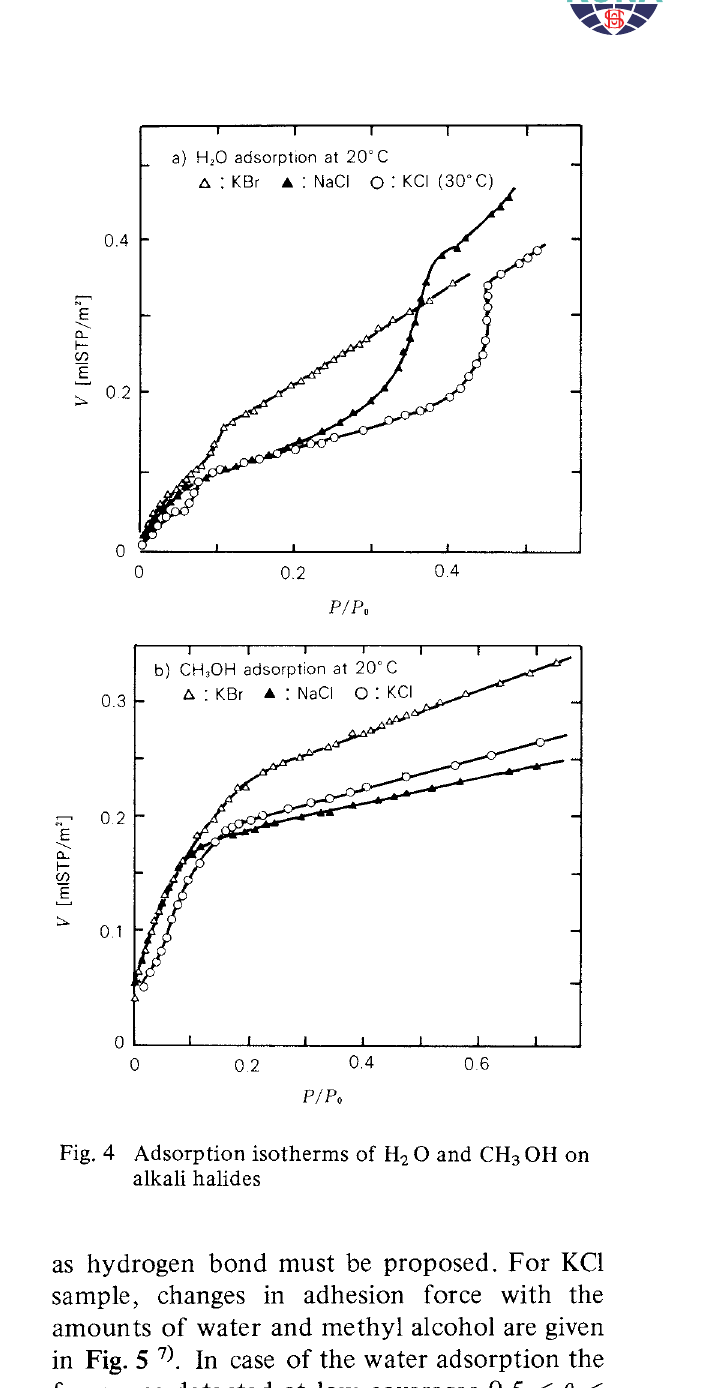
Fig. 4 Adsorption isotherms of H 2 0 and CH 3 OH on alkali